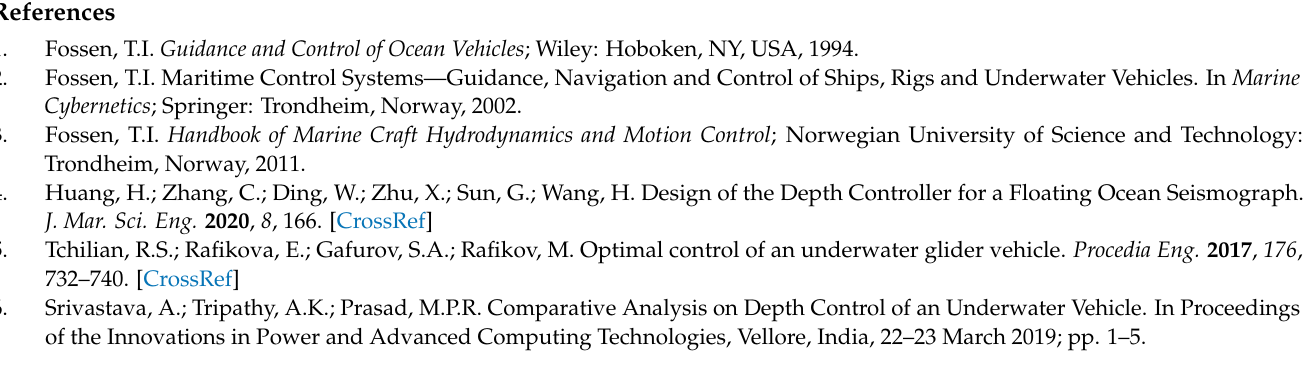
Figure 29. Clustered cone bar graph of various controllers.